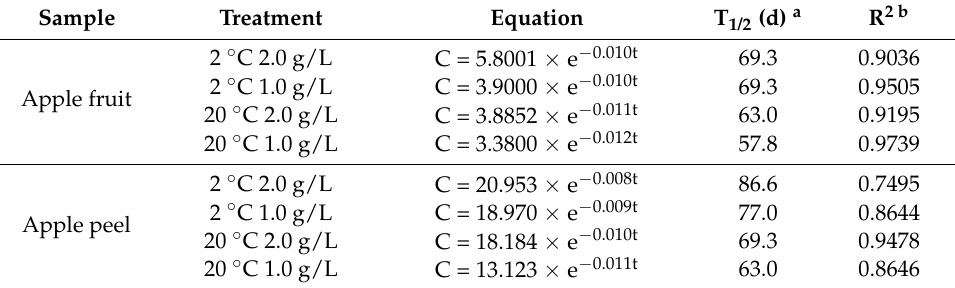
Table 3. Statistical data of prochloraz dissipation in apple fruit and apple peel.